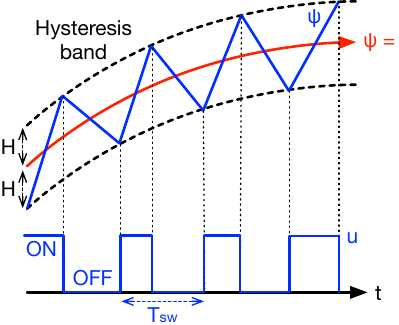
Figure 8. Hysteresis band to limit the switching frequency.